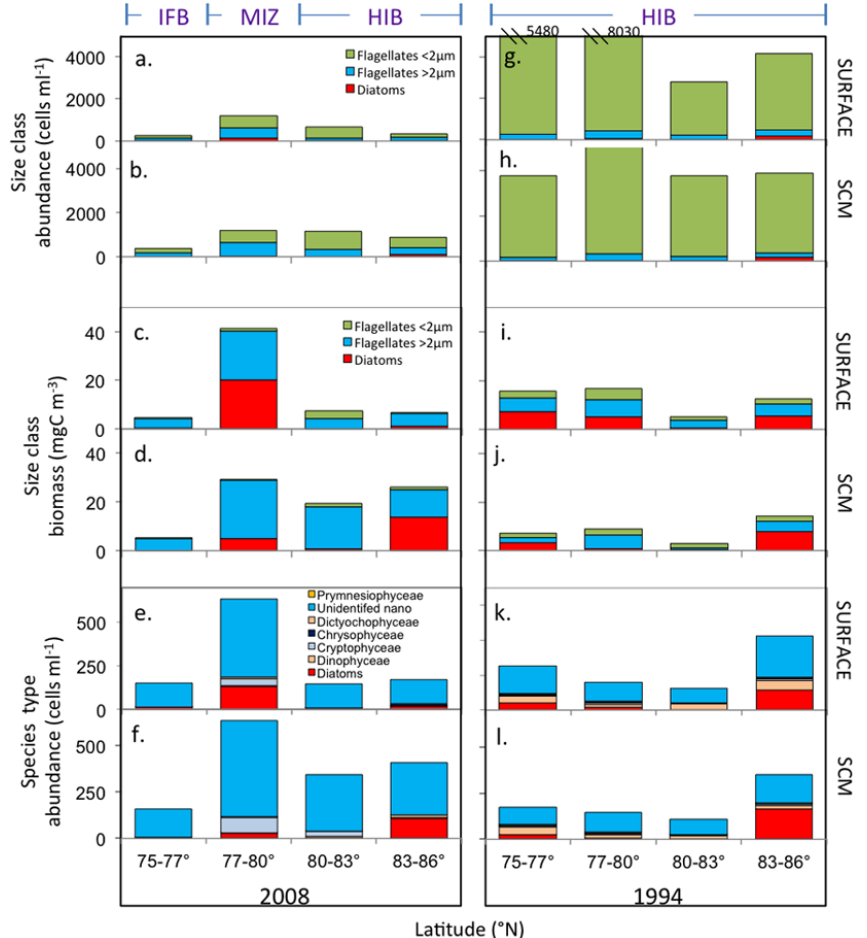
Fig. 7. Comparison of the taxonomic distribution of phytoplankton obtained during the R/V CHINARE 2008 (left panels) and R/V AOS 1994 (right panels) cruises. The phytoplankton abundance (a, b, g, h) and biomass (c, d, i, j) of three size classes: flagellates ( < 2µm), flagellates ( > 2µm) and diatoms and the abundances of the main seven planktonic taxa (e, f, k, l) are averaged over four latitude ranges in surface and at the